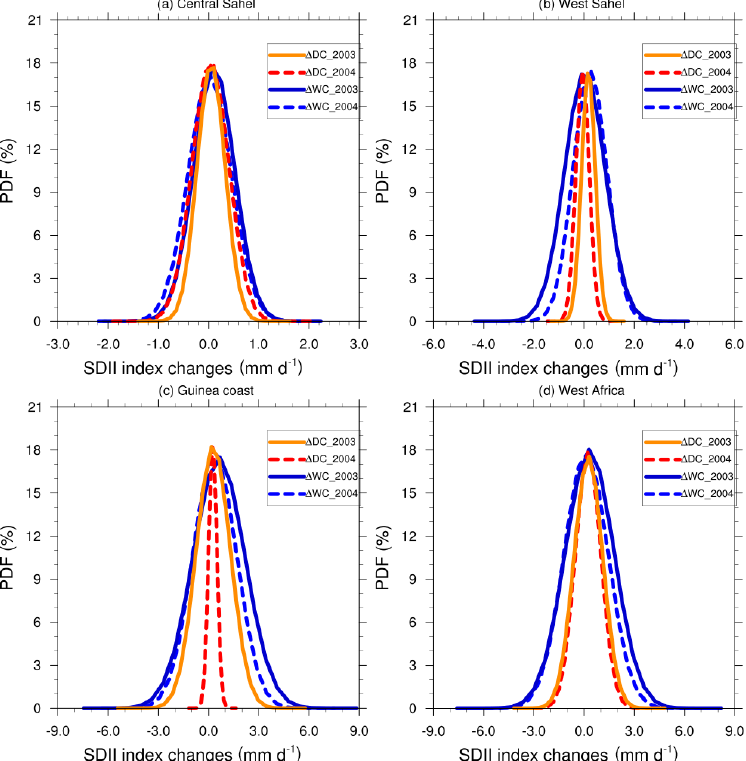
Hydrol. Earth Syst. Sci., 26, 731–754, 2022